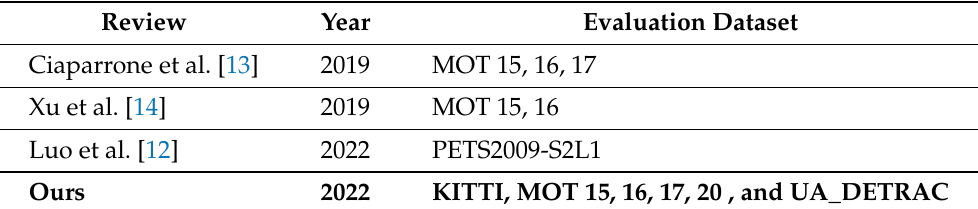
Table 1. Recent reviews and the data used for evaluation and